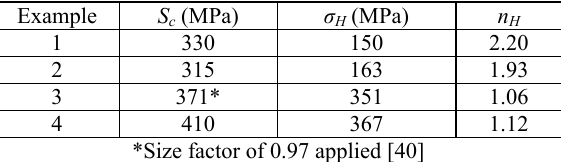
Table 4: Apparent Pitting Design Factor for Examples